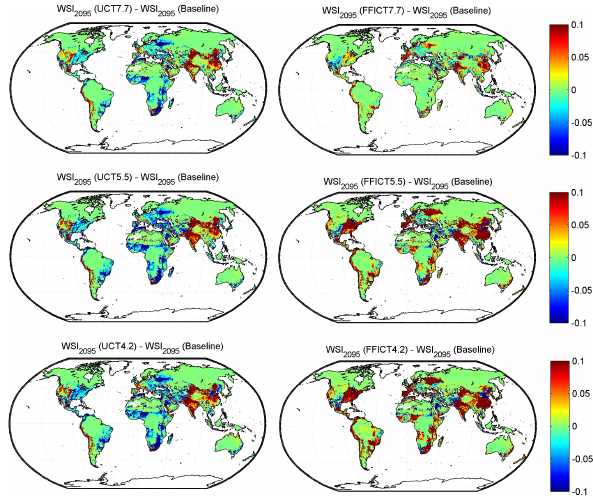
Figure 13: The effect of climate change mitigation policies on the magnitude of the WSI; all six policy scenarios are compared to the baseline scenario (A1fi) in 2095